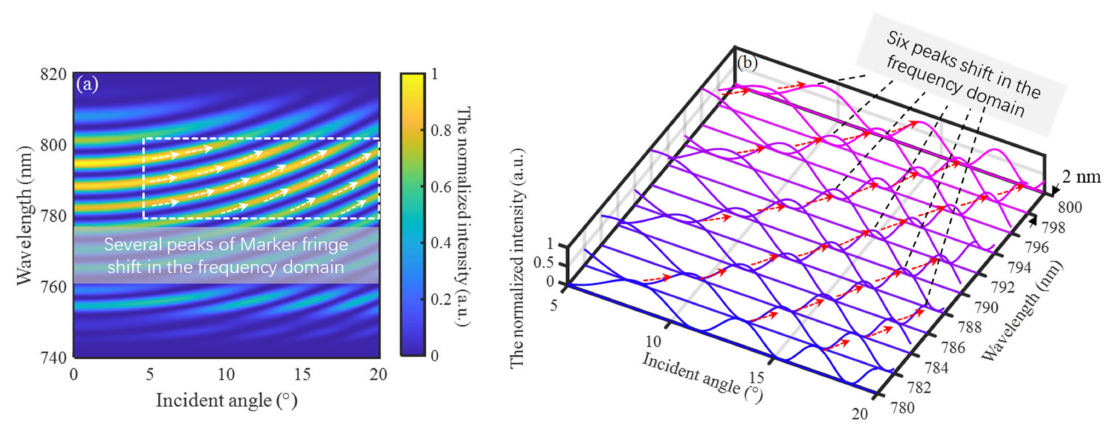
Figure 9. The Maker fringe shift of p-s polarization of LiNbO 3 . ( a ) The 2D plot; ( b ) 3D plot in the higher intensity